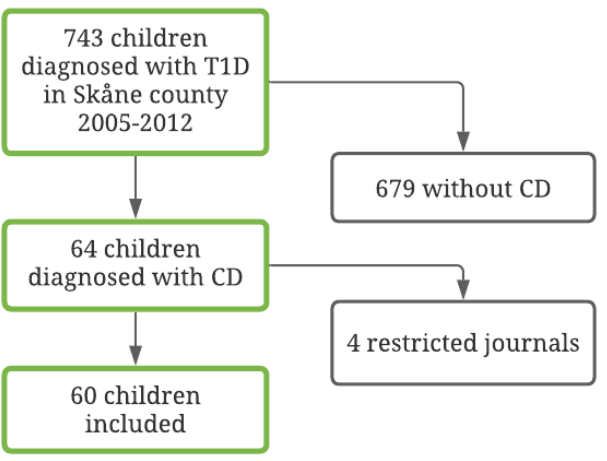
Figure 1. Flow chart of the included diabetes population, 2005–2012. Table 1. Demographic and clinical variables in the full sample and across compliance subsamples.